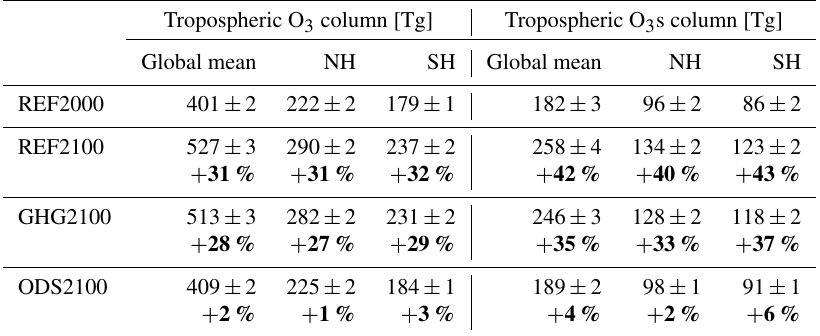
Figure 9. Same as Fig. 6, but for the change in the tropospheric columns of O 3 [DU] (a, d, g) , the tropospheric columns of O 3 s [DU] (b, e, h) , and the contribution of the O 3 s changes to the O 3 changes between 2000 and 2100 [%] (c, f, i) . The small numbers on top of the figures are the respective annual mean and global mean changes in Dobson units and percent. Shading in the bottom row indicates the regions where both O 3 s and O 3 changes are significant at the 95% confidence level. Table 3. Overview of the annual mean O 3 and O 3 s burden [Tg] in the troposphere with the corresponding standard deviations in the EMAC time-slice simulations. Bold numbers indicate the change relative to the REF2000 simulation. All changes are significant at the 95% confidence